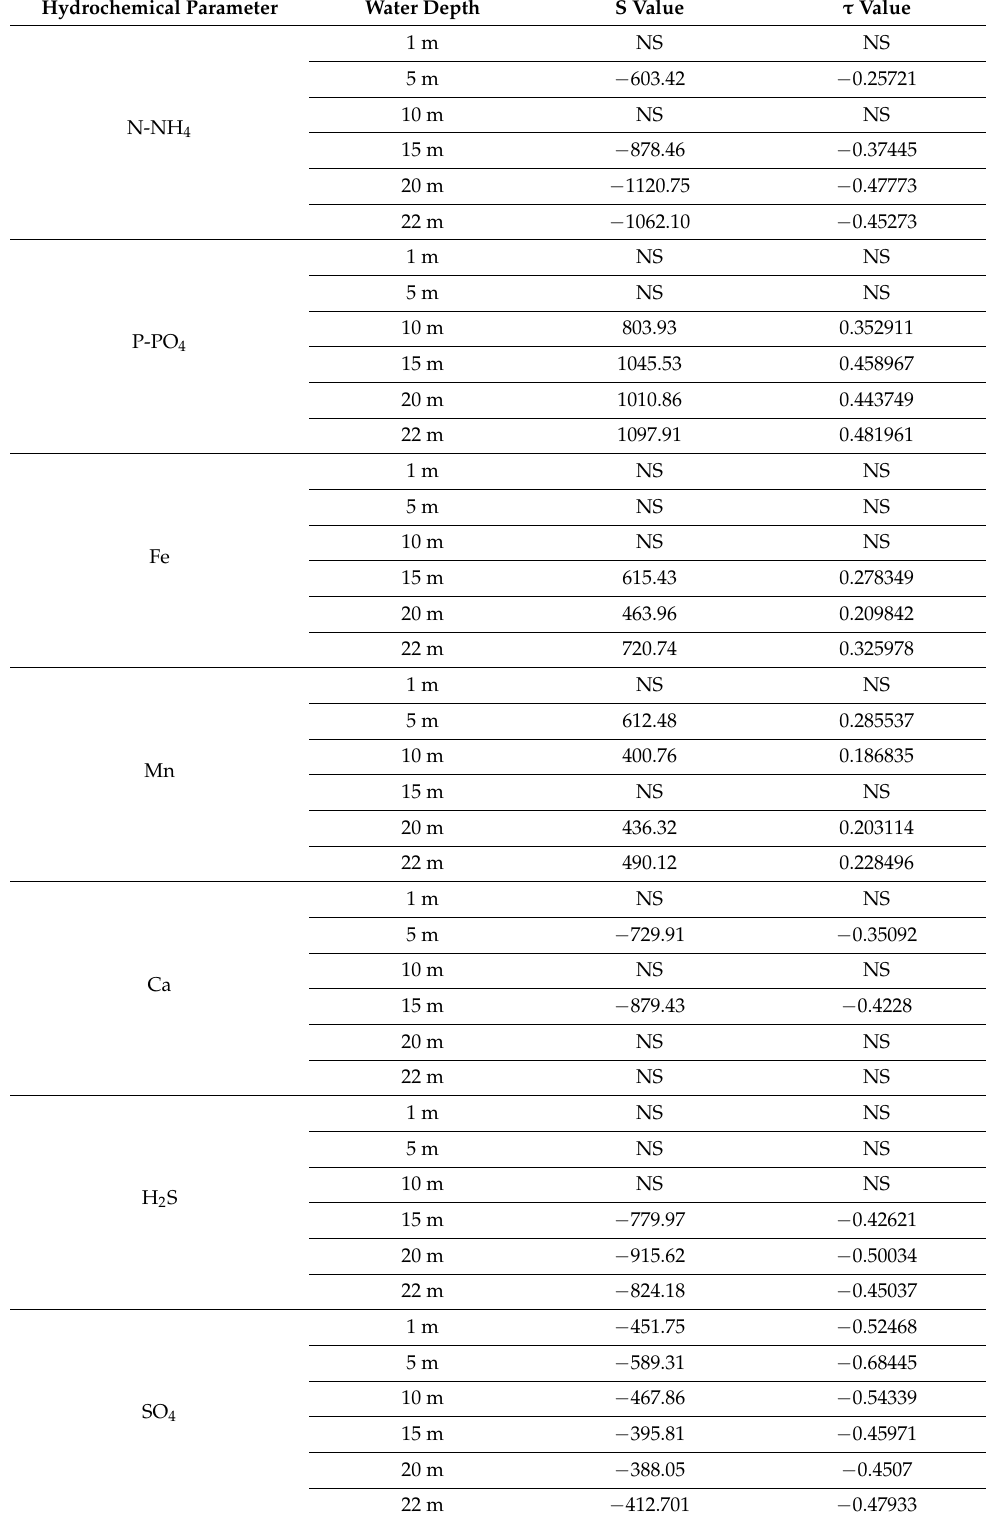
Table 2. Results of the Mann–Kendall analysis. Significant results ( p < 0.05) are presented. Other results are indicated as NS